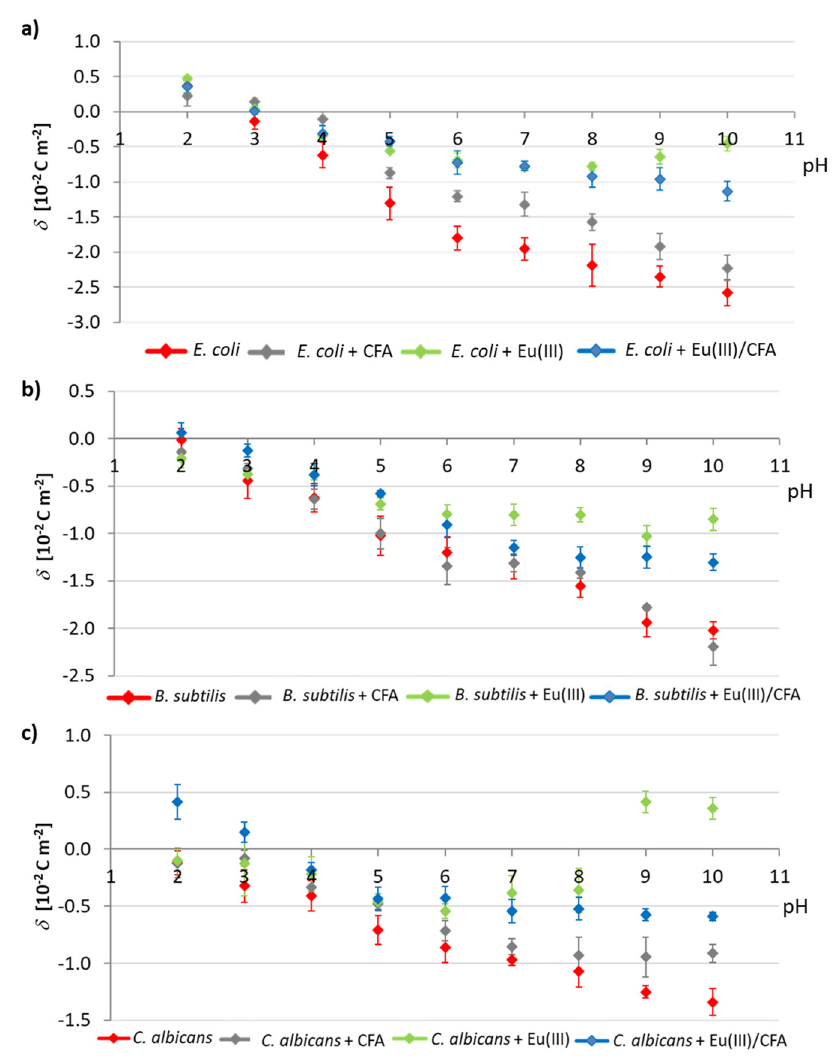
Figure 11. Influence of CFA, Eu(III) and Eu(III)/CFA system on the surface charge of: ( a ) E. coli , ( b ) B. subtilis and ( c ) C. albicans membranes.